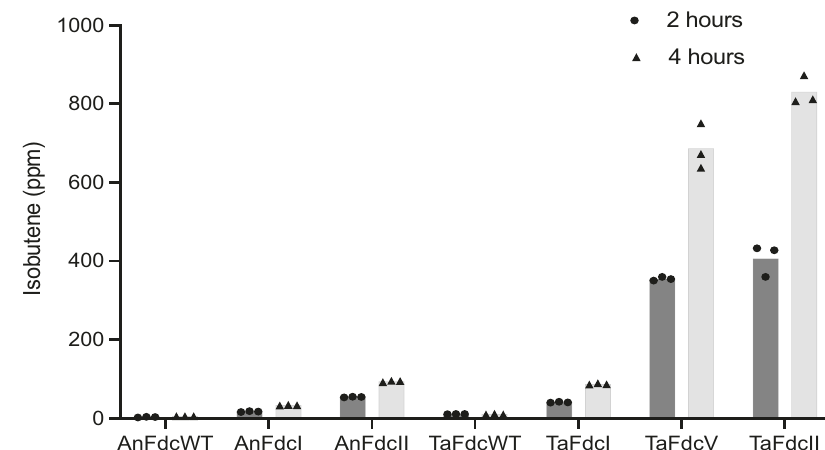
Fig. 5 Isobutene production by Ta Fdc and An Fdc variants. 3-methylcrotonate decarboxylation assay with puri fi ed enzyme comparing isobutene production as detected by GC by Ta Fdc and An Fdc variants (Table 1), both with N-terminal His-tags, over 2 and 4 h with 10 mM 3-methylcrotonate and 0.3 mg/mL enzyme. Fold increase comparison is shown in Supplementary Fig. 7. Source data are provided as a Source Data fi